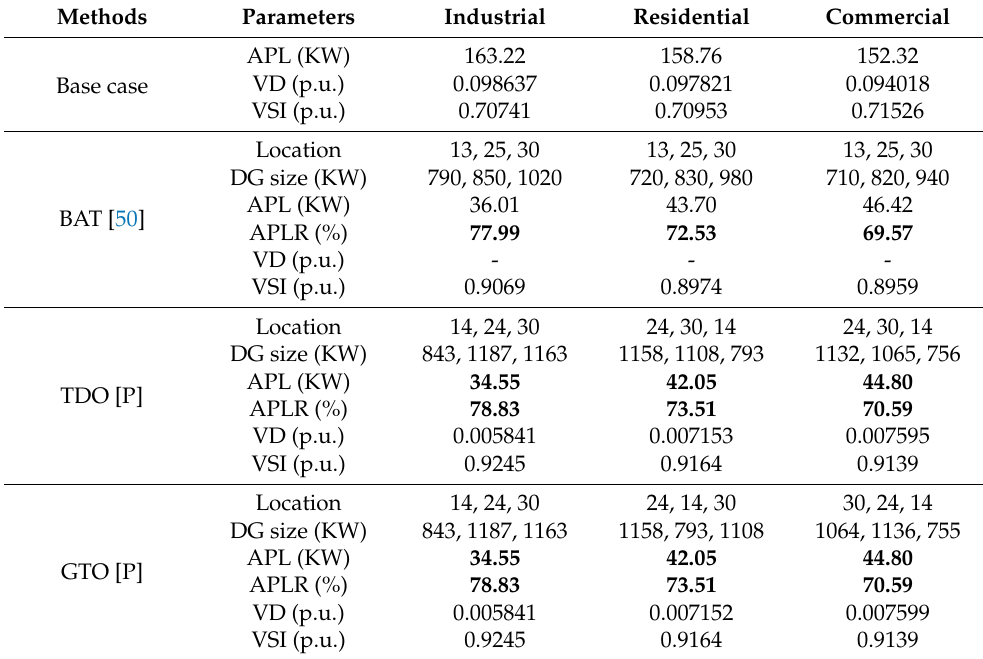
Table 6. Results comparison of OADG for 33 bus RDN for the SOF (APL minimization) at unity pf (PV type) in the VP load model.